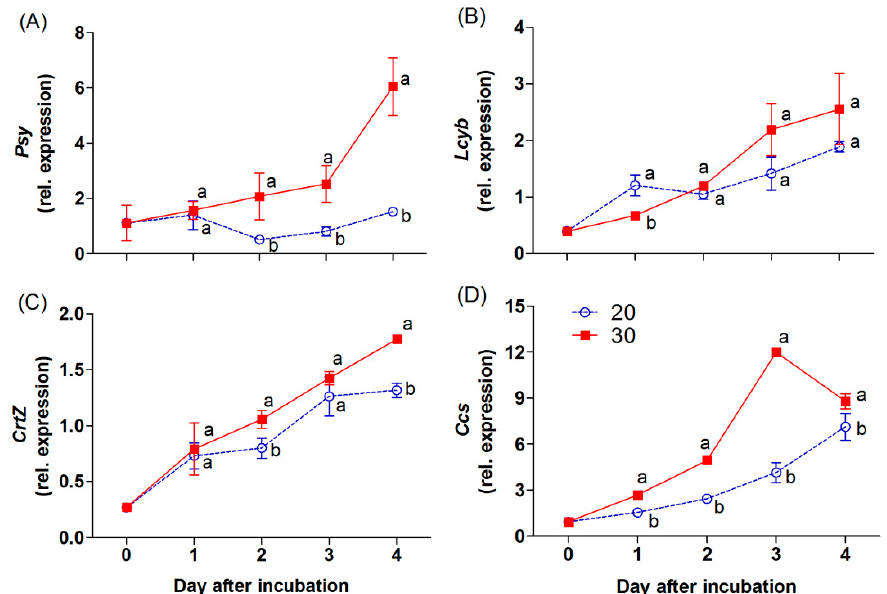
Figure 5. Effect of incubation temperatures at 20 and 30 °C on the relative expression levels of Psy ( A ), Lcyb ( B ), CrtZ ( C ), and Ccs ( D ) of “Takanotsume” chili for 4 days. Values are means ± SD ( n = 3). Different letters indicate a significant difference between temperatures on the same day of incubation ( p ≤ 0.05).